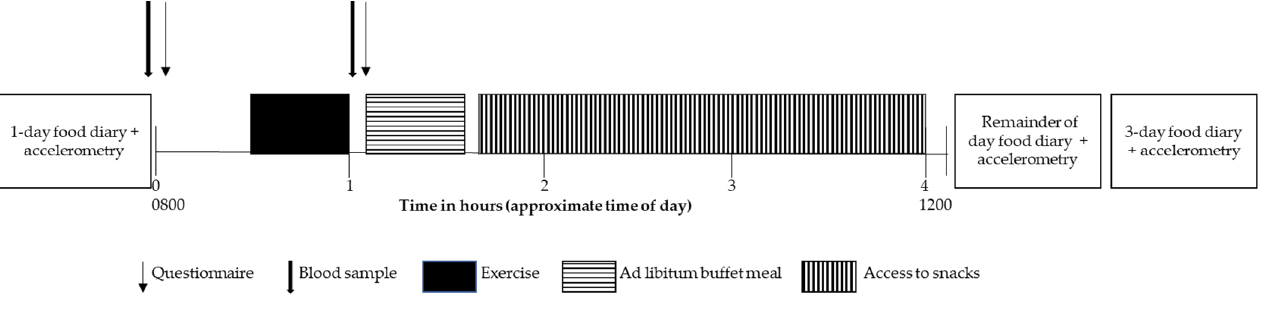
Figure 2. Visit 2